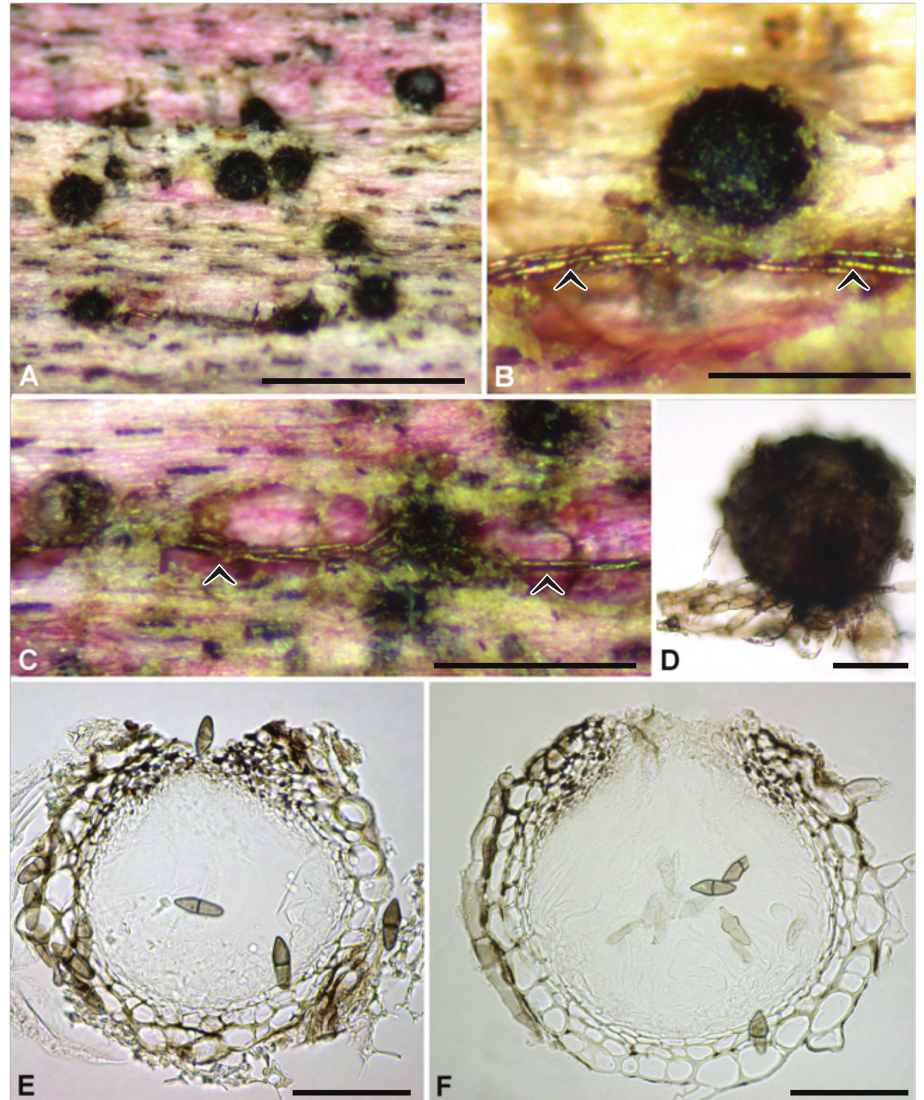
Figure 1. A–F Jahnula purpurea (from the HOLOTYPE; MJF 14016, ILLS 72402). A–C Ascomata on submerged wood. Note the purple stain. Arrowheads indicate the subtending superficial hyphae on wood, which connect multiple ascomata on wood D Ascoma in water showing broad hyphae emerging from the base of the fruiting body E, F Longitudinal section through ascoma. Note broad pseudoparenchymatic cells comprising the peridial wall. Scale bars: A, C = 500 µm; B = 1 mm; D = 100 µm; E–F = 20 µm; golden brown hyphae 8–22 µm diam, smooth, slightly constricted at septa; hyphae form cords developing under the wood surface and linking adjacent ascomata (Fig. 1A– D); wood beneath ascomata or at the periphery of the colony stained purple;